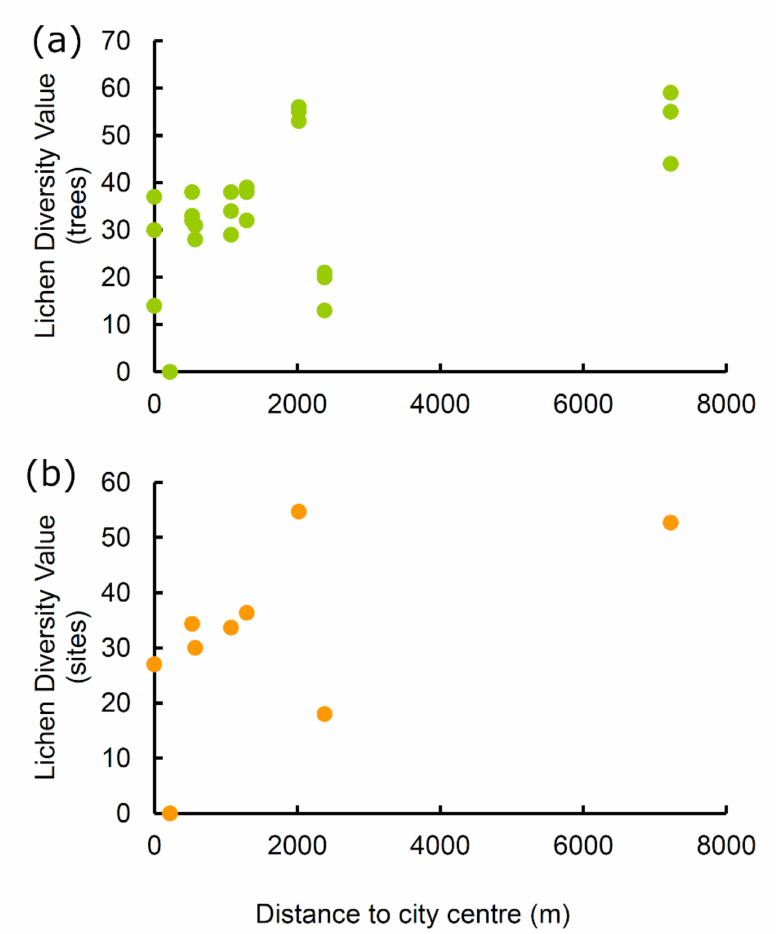
Figure 1. Relationship between Lichen Diversity Values and distance from the city centre along an urban–rural gradient in the city of L’Aquila (Central Italy). Lichen Diversity Values were calculated at: ( a ) tree level and ( b ) site level.